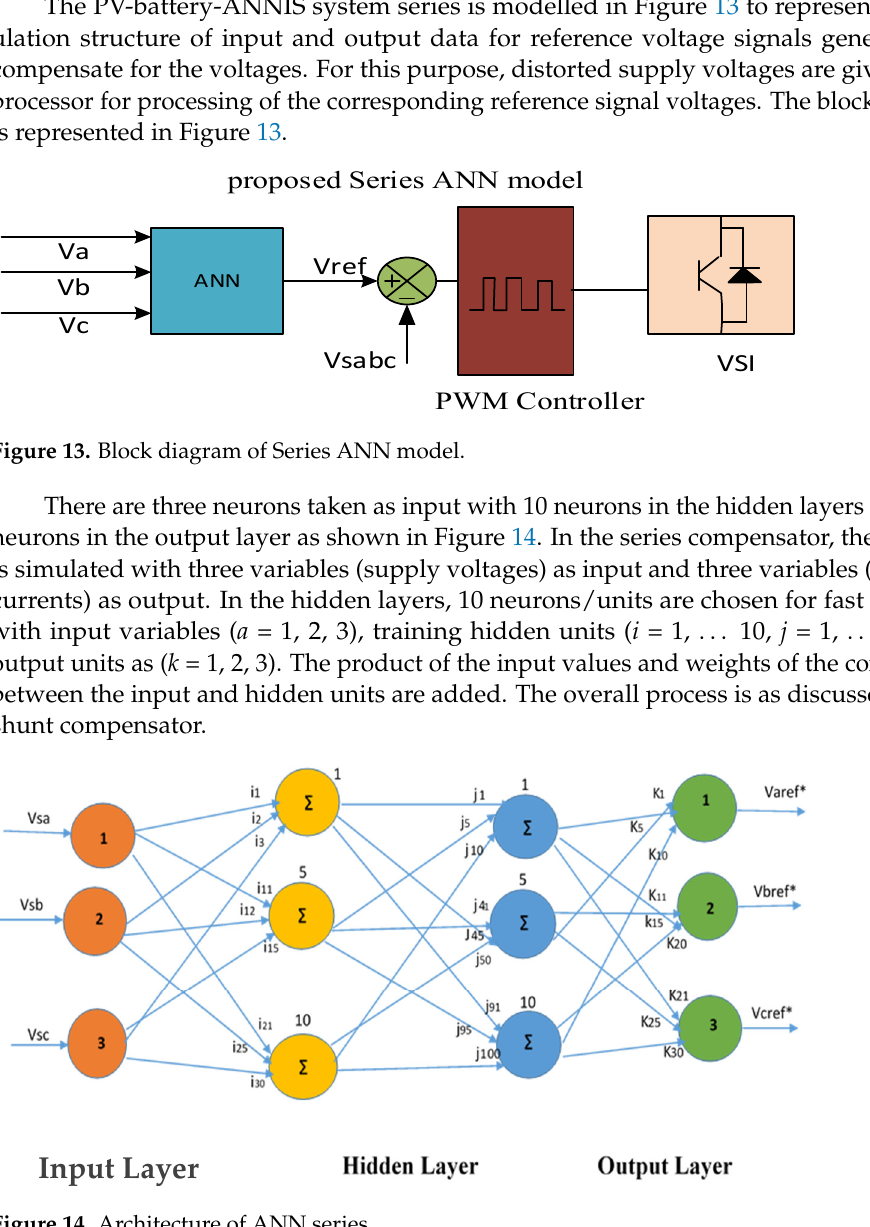
Figure 14. Architecture of ANN series.